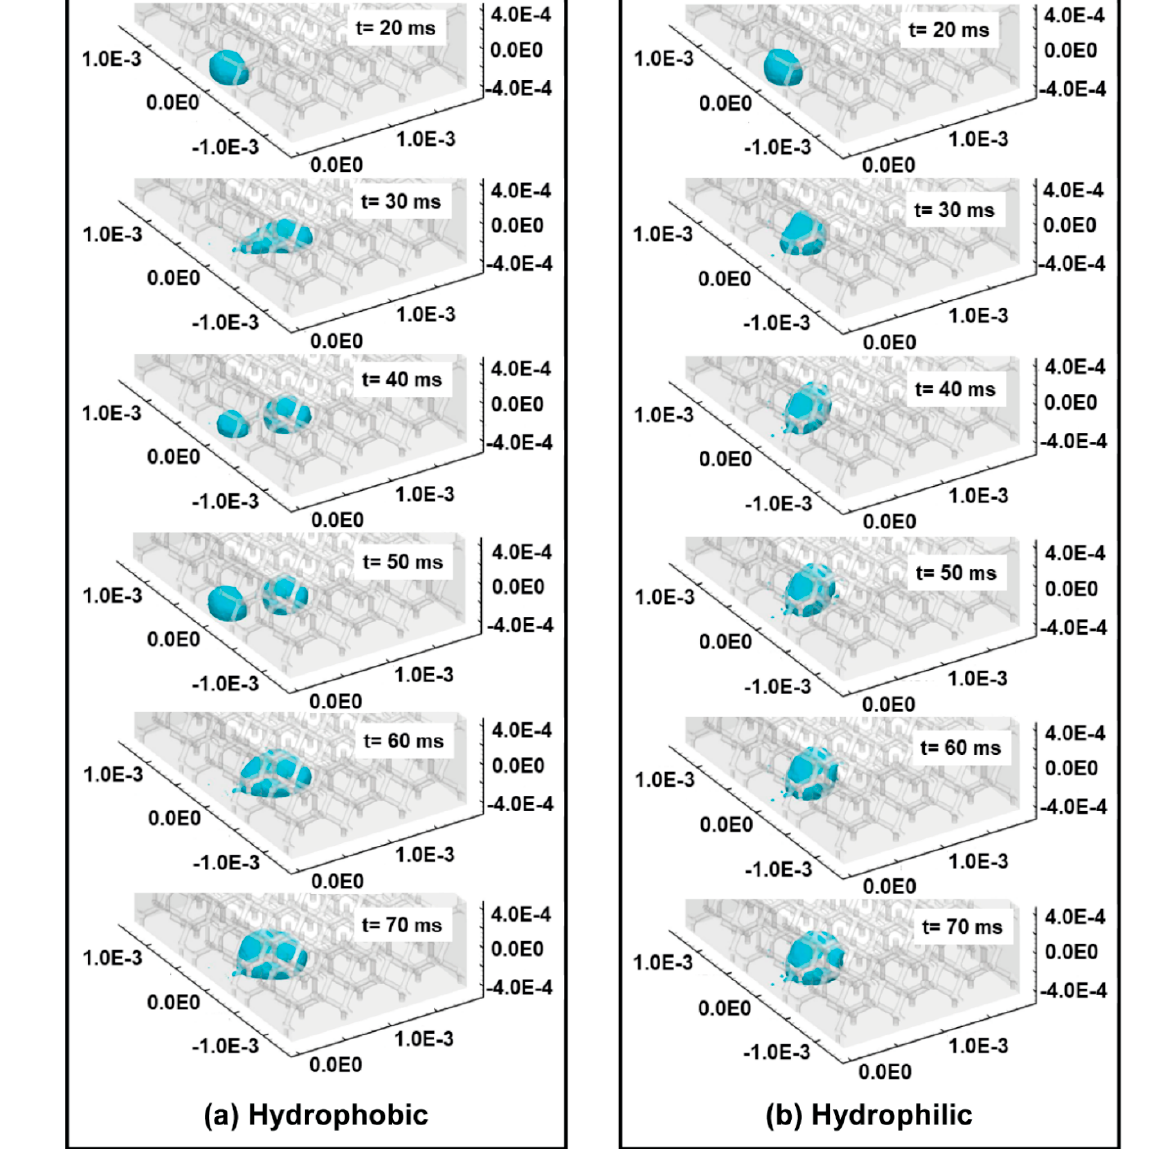
− 1 ( a ) hydrophobic